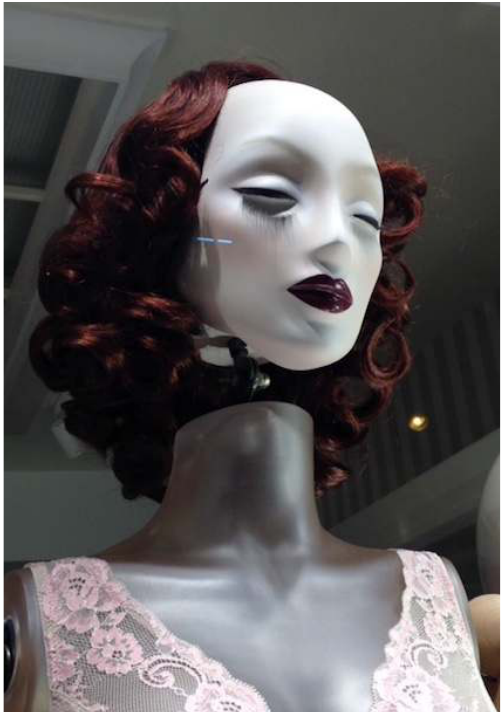
muscles. Des pans entiers de votre squelette — votre bras droit, par exemple —